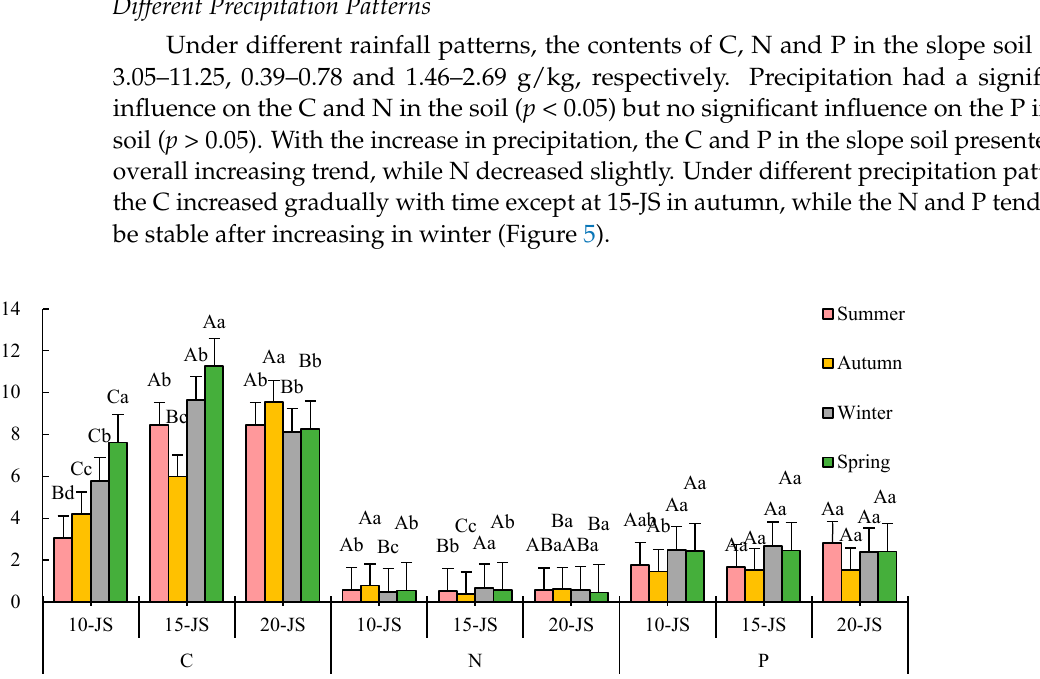
Figure 4. The C/N, C/P and N/P of plants under different precipitation patterns. Note: ( a ) C/N of the Cynodon, ( b ) C/P of the Cynodon, ( c ) N/P of the Cynodon, ( d ) C/N of the Indigofera Amblyantha Craib, ( e ) C/P of the Indigofera Amblyantha Craib, ( f ) N/P of the Indigofera Amblyantha Craib; capital letters on different columns indicate that the same plant organ in the same season were significantly different under different precipitation ( p < 0.05); lowercase letters on different columns indicate that the same plant organ had significant differences in different seasons under the same precipitation ( p < 0.05).